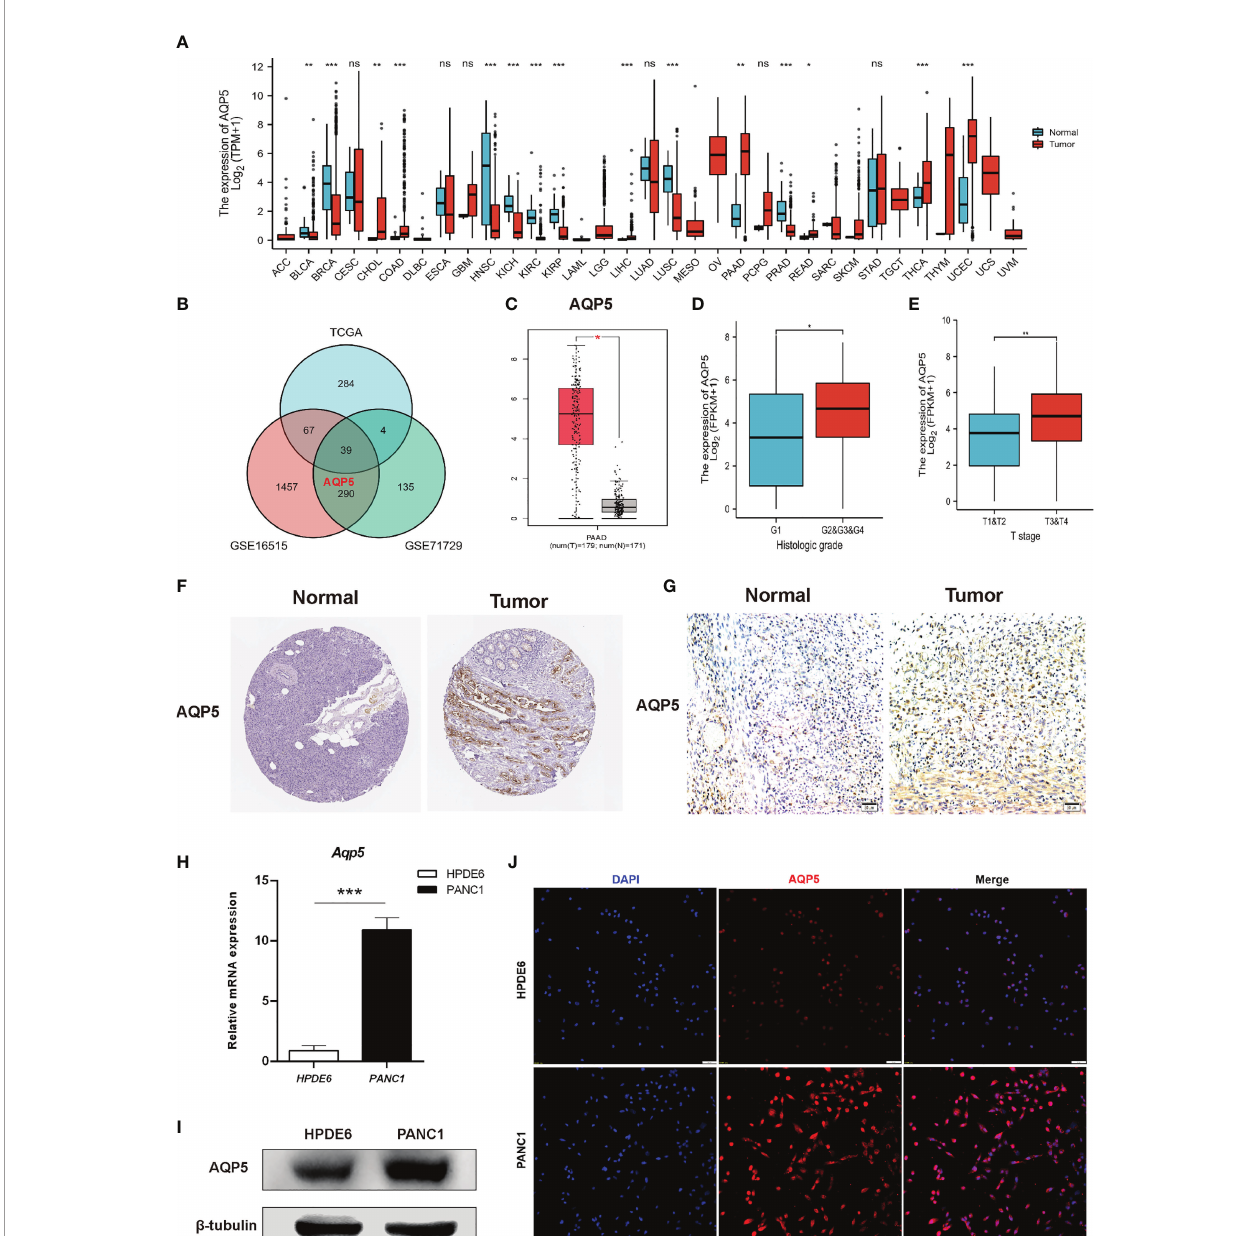
FIGURE 2 | The expression of gene AQP5 mRNA in different kinds of tumors and its relationship with clinical parameters in PAAD. (A) Human expression levels of AQP5 in 33 various malignant tumor types from The Cancer Genome Atlas (TCGA) database were analyzed by the Tumor Immune Estimation Resource (TIMER). (B) Venn diagram showing the common differential expression genes in three public databases (TCGA, GES16515, and GES71729). (C) The expression of AQP5 in PAAD and normal pancreatic tissues, respectively. (D, E) Association between AQP5 expression and clinicopathologic characteristics with PAAD patients ’ cancer grade (D) and pathological T stage (E) . The immunohistochemistry of AQP5 in PAAD and normal pancreatic tissue (F, G) . (H – J) AQP5 mRNA and protein levels were overexpressed compared with real-time PCR (H) , Western blotting (I) , and immuno fl uorescence (J) . * p < 0.05, ** p < 0.01, *** p < 0.001, NS, not signi fi